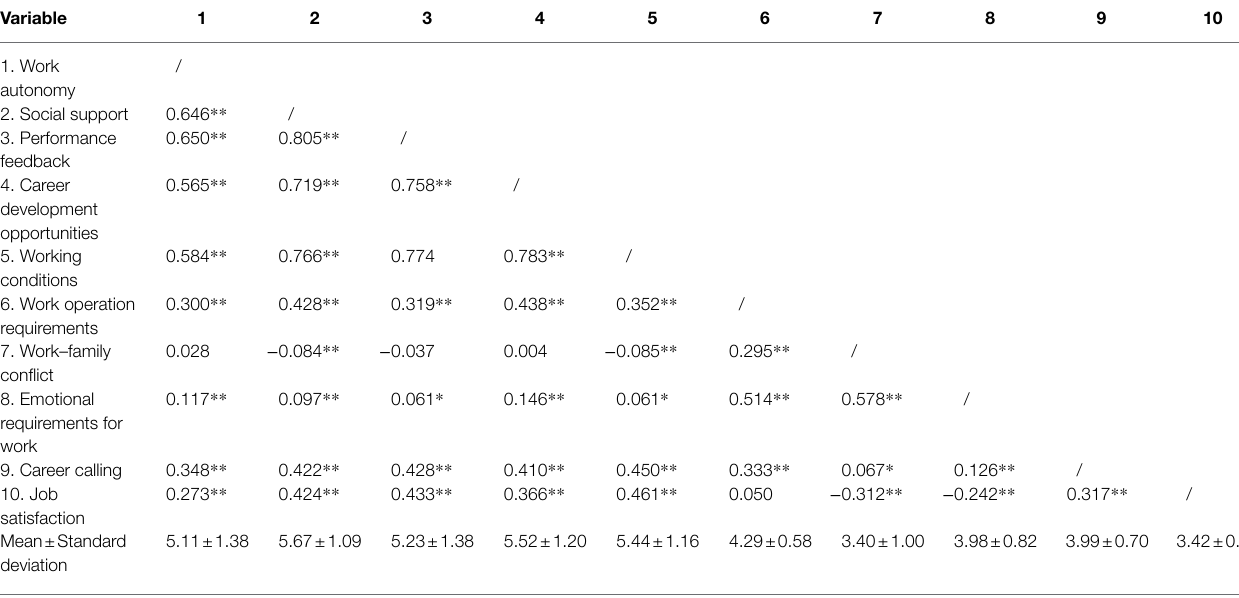
TABLE 3 | Mean, standard deviation, and correlation coefficient of each variable.